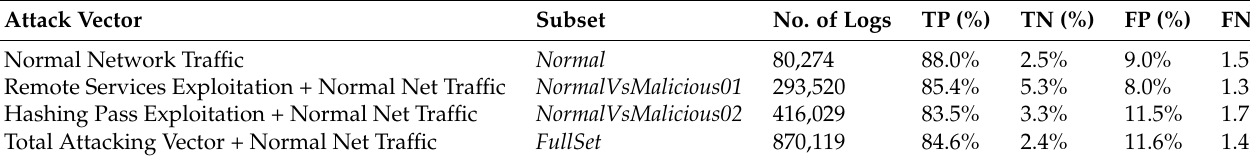
Table 5. Total number of tests performed with PeX per attack and subset, including FP and TP